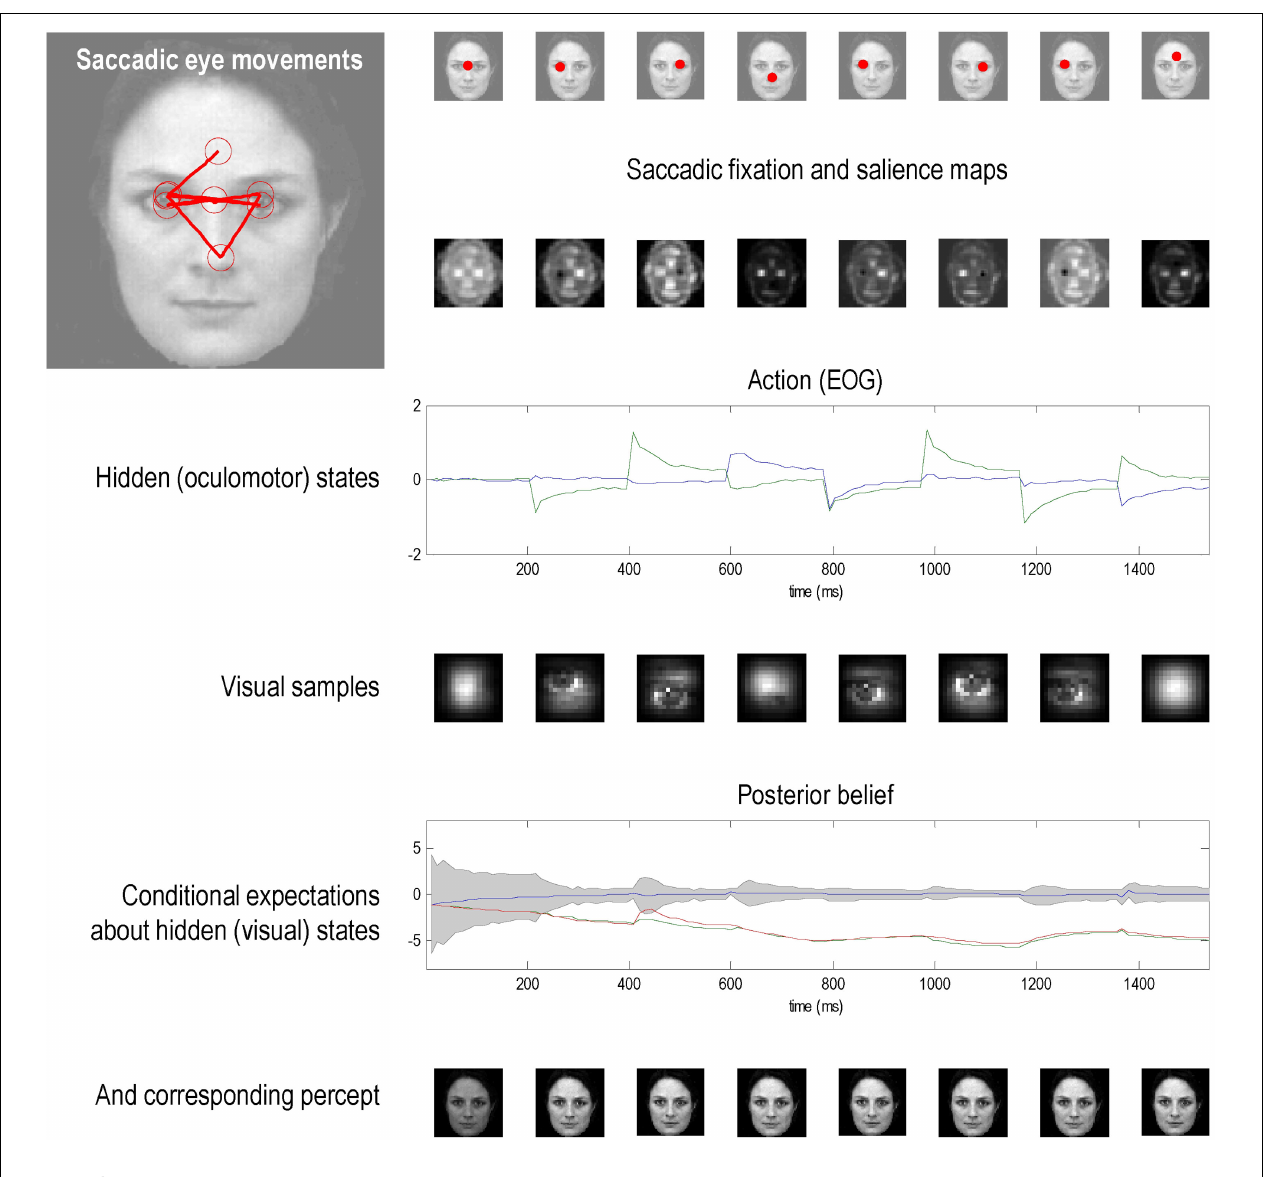
FIGURE 5 |This figure shows the results of the first simulation, in which a face was presented to an agent, whose responses were simulated using the optimal inference scheme described in the main text. In this simulation, the agent had three internal images or hypotheses about the stimuli it might sample (an upright face, an inverted face, and a rotated face).The agent was presented with an upright face and its conditional expectations were evaluated over 16 (12ms) time bins until the next saccade was emitted.This was repeated for eight saccades.The ensuing eye movements are shown as red dots at the location (in extrinsic coordinates) at the end of each saccade in the upper row.The corresponding sequence of eye movements is shown in the insert on the upper left, where the red circles correspond roughly to the proportion of the image sampled. These saccades are driven by prior beliefs about the direction of gaze based upon the saliency maps in the second row. Note that these maps change with successive saccades as posterior beliefs about the hidden states, including the stimulus, become progressively more confident. Note also that salience is depleted in locations that were foveated in the previous